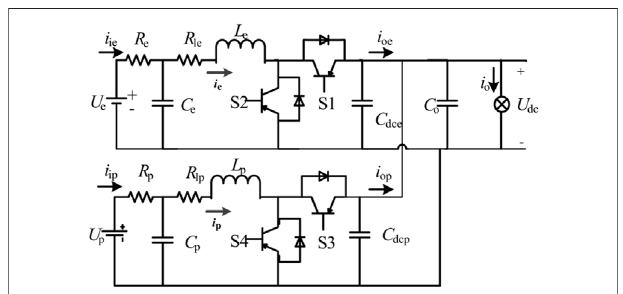
FIGURE 2 | Single HES module topology.